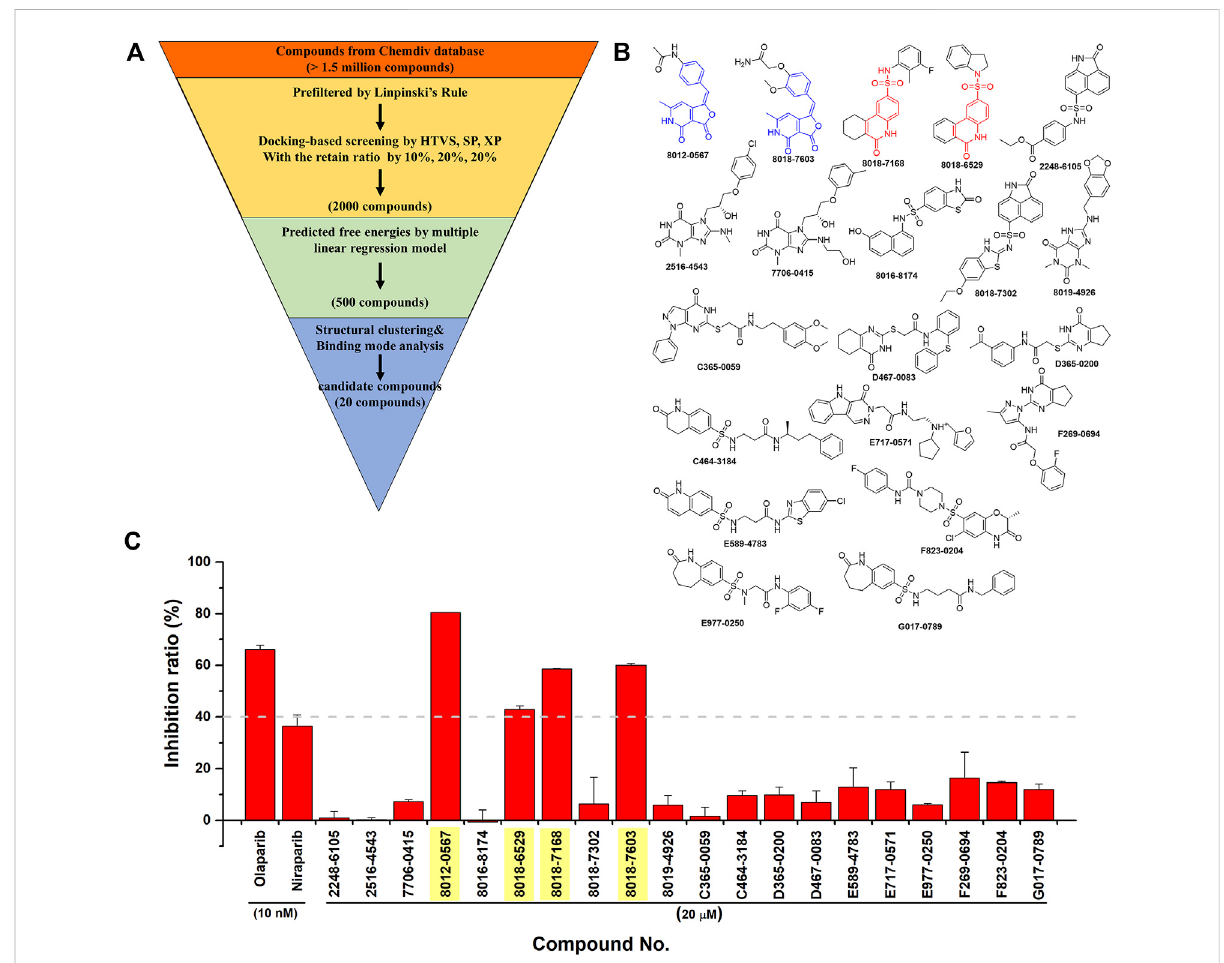
FIGURE 4 The integrated in silico screening work fl ow and in vitro inhibitory activity assay of candidate compounds. (A) The in silico screening work fl ow. (B) The chemical formula of 20 compounds selected for in vitro assay. The scaffolds of four hit compounds are labeled out with arylidenefuropyridinediones (compound 8012-0567 and 8018-7603) in blue and 1,2-Dihydro-2-oxo-6-quinolinesulfonamide (compound 8018- 7168 and 8018-6529) in red. (C) The inhibitory activities of two positive controls and 20 candidate